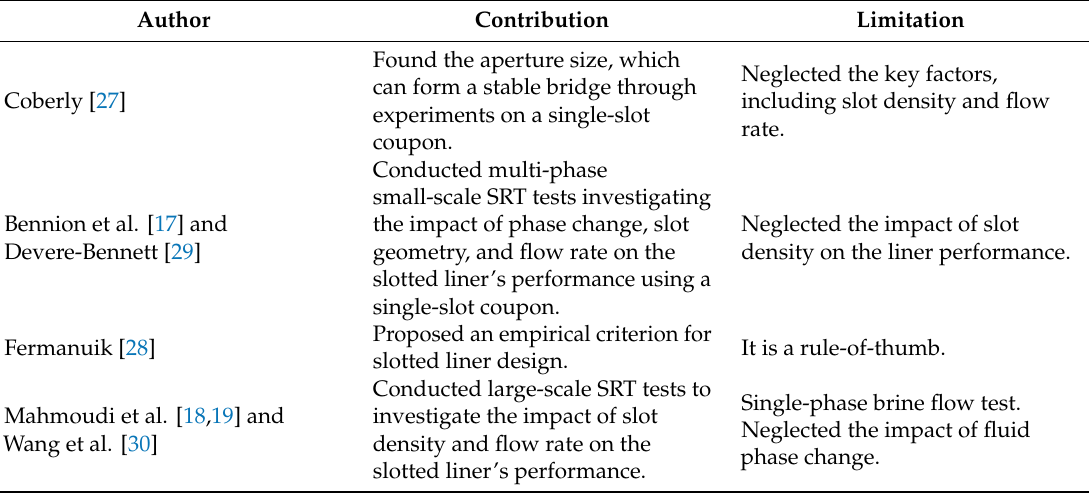
Table 1. Summary of current design